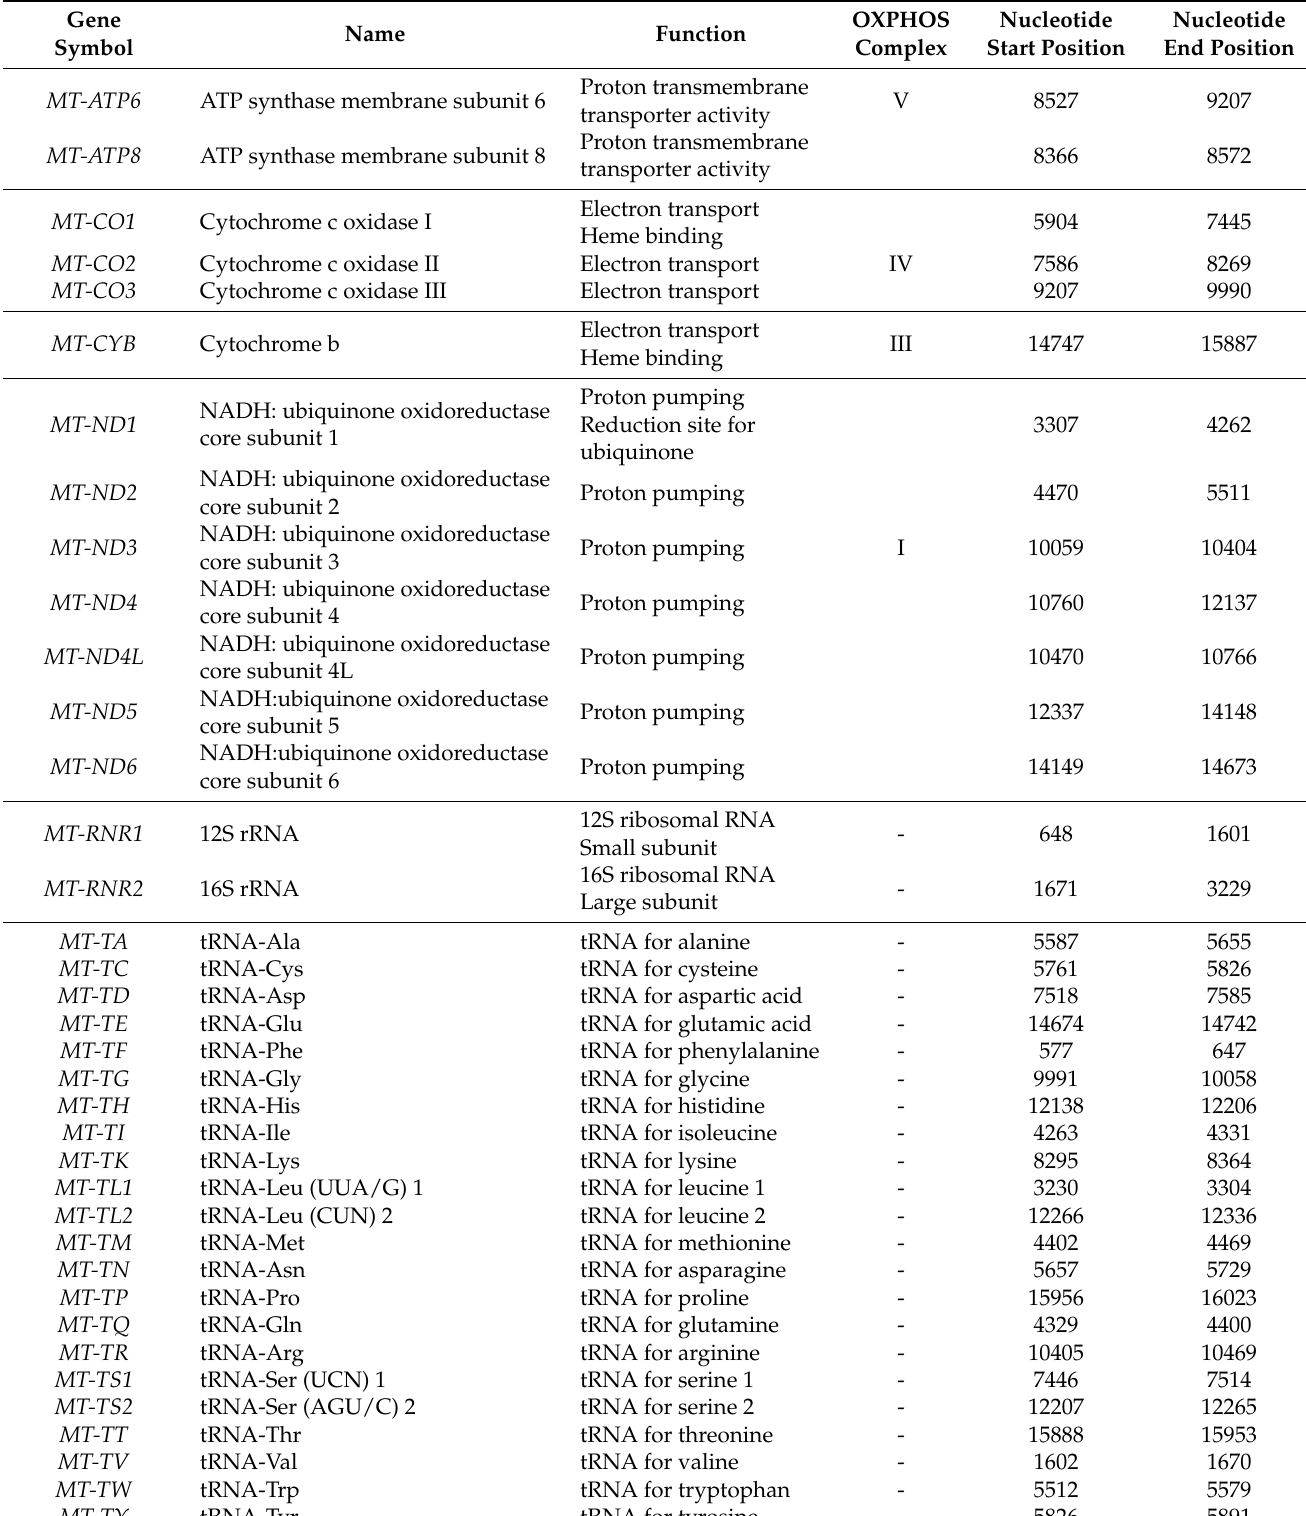
Table 1. Encoded mitochondrial DNA